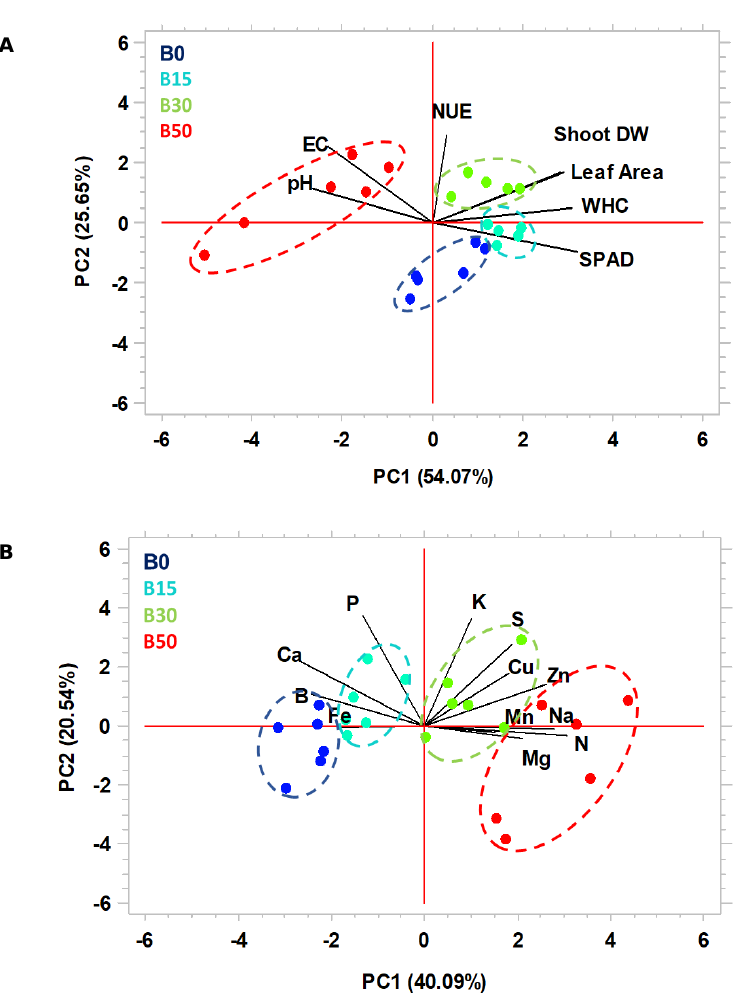
Figure 3. PCA biplot with the first two PCA axes, with projected centroids of peat:biochar treatments (B0-dark blue, B15-light blue, B30-green, B50-red). ( A ) Substrate parameters (pH, EC and WHC) and plant parameters (Shoot DW, Leaf area, SPAD, NUE) are shown. ( B ) Nutrients content (N, P, S, Mg, Ca, K, Fe, Mn, Cu, Zn, B and Na) detected in plants are shown. The first PCA analysis was performed using both substrate (pH, EC, WHC) and plant (Shoot DW, Leaf area, SPAD, NUE) parameters. The first two axes explain 79.71% (PC1: 54.07%; PC2: 25.65%) of the total variance (Figure 3A). A second PCA was per- formed using the content of nutrients (N, P, S, Mg, Ca, K, Fe, Mn, Cu, Zn, B, Na), with the two axes explaining 61.45% (PC1: 40.09%; PC2: 20.54%) of the total variance (Figure 3B). The effectiveness of the PCA results in interpreting the differences across different substrates and plant parameters in response to rising biochar exposure. In the current study, the loading matrix indicates that variation in substrate factors, such as pH and EC, are most closely aligned with the B50 treatment. In contrast to this, plants grown under